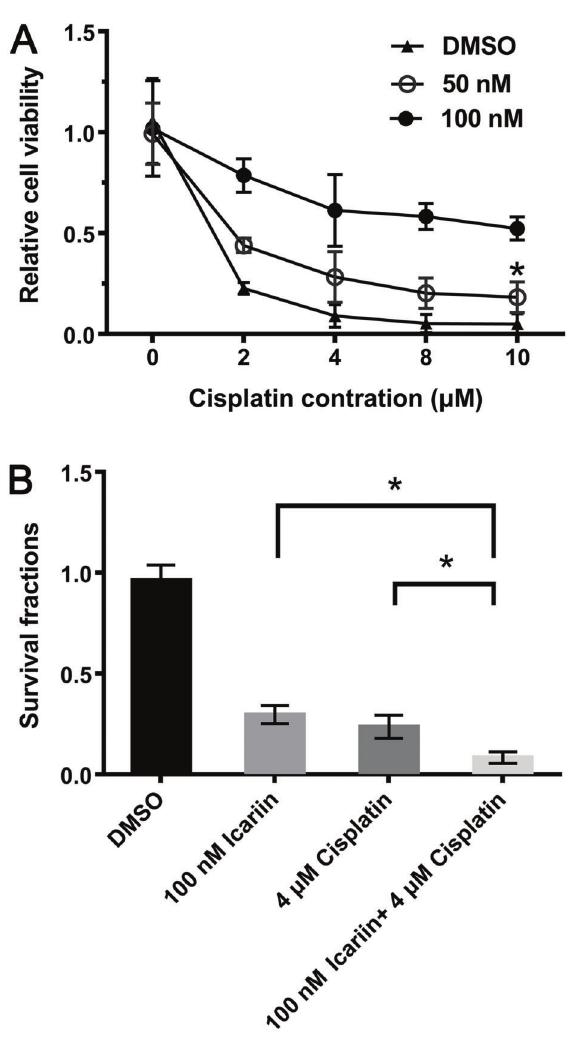
Figure 3. Icariin enhanced the anti-tumor effect of cisplatin on colon carcinoma cells. The effect of icariin and cisplatin in combi- nation on cell growth was detected by A , CCK-8 assay and B, colony formation assay. Assays were performed in triplicate. Data are reported as means ± SD. *P o 0.05